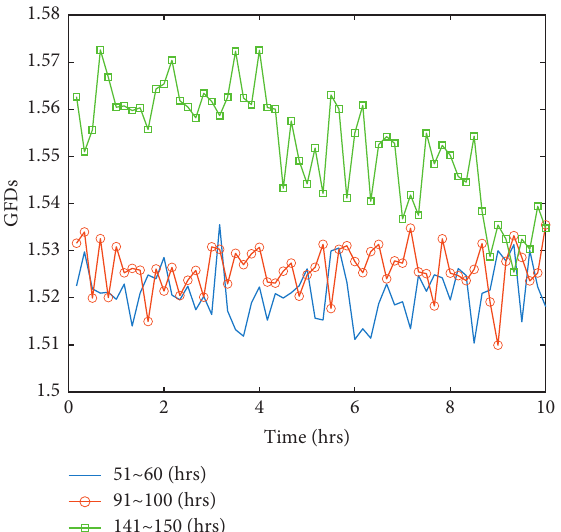
Figure 10: GFDs comparison diagram of different intervals of bearing no.